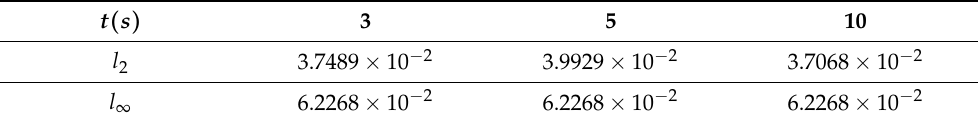
Table 1. l 2 and l ∞ norms of the errors in Example 2.